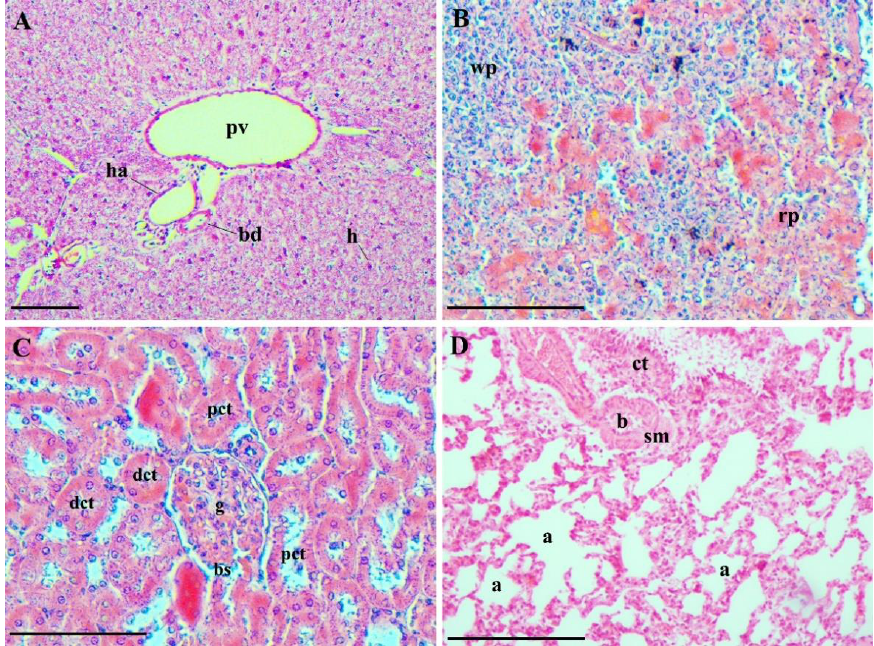
Figure 7. Representative photomicrographs of the evaluated vital organs: ( A ) liver (MNH-D28 group)—elements of the hepatic triad, branches of the portal vein (pv), a branch of the hepatic artery (ha), and a small bile duct (bd) are shown. Hepatocytes (h) are arranged in plaques radiating from the central venule regions and extend to the portal areas; ( B ) spleen (MNH-D7 group)—red and white pulp are distinguishable. The red pulp (rp) has several splenic cords, among which the sinusoids are located, and the white pulp (wp) is made up of lymphatic tissue, predominantly lymphocytes; ( C ) kidneys (MNH-D56 group)—note the glomerular capillaries (g) of a renal corpuscle, Bowman’s space (bs), proximal (pct) and distal (dct) convoluted tubules with normal appearance; and ( D ) lungs (MNH-D56 group)—the lungs of all animals were similar, and it was possible to observe pulmonary alveoli (a), alveolar sacs, bronchioles (b), pulmonary blood vessels, connective tissue (ct) and smooth muscle (sm). Bars = 10 µ